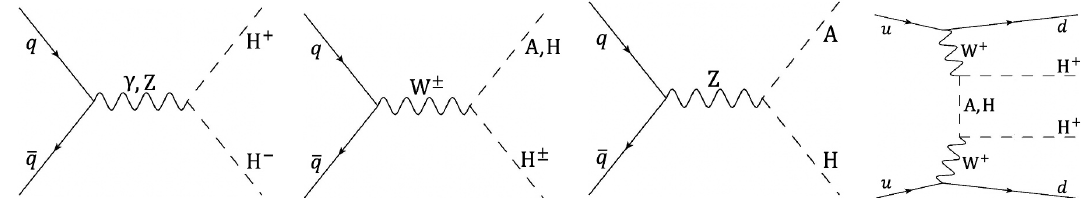
Figure 2 . Representative Feynman diagrams for scalar pair